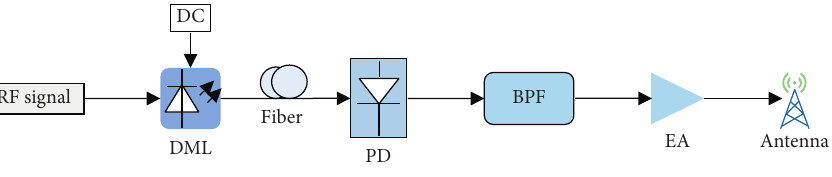
Figure 1: DML scheme structure